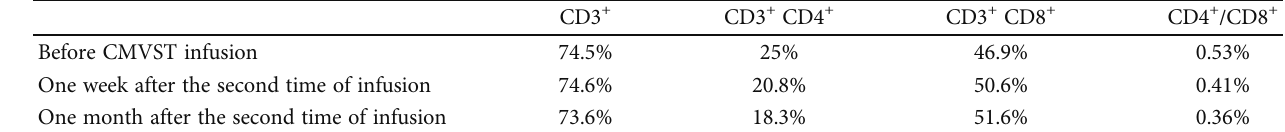
Table 1: T cell subsets after CMVST infusion.